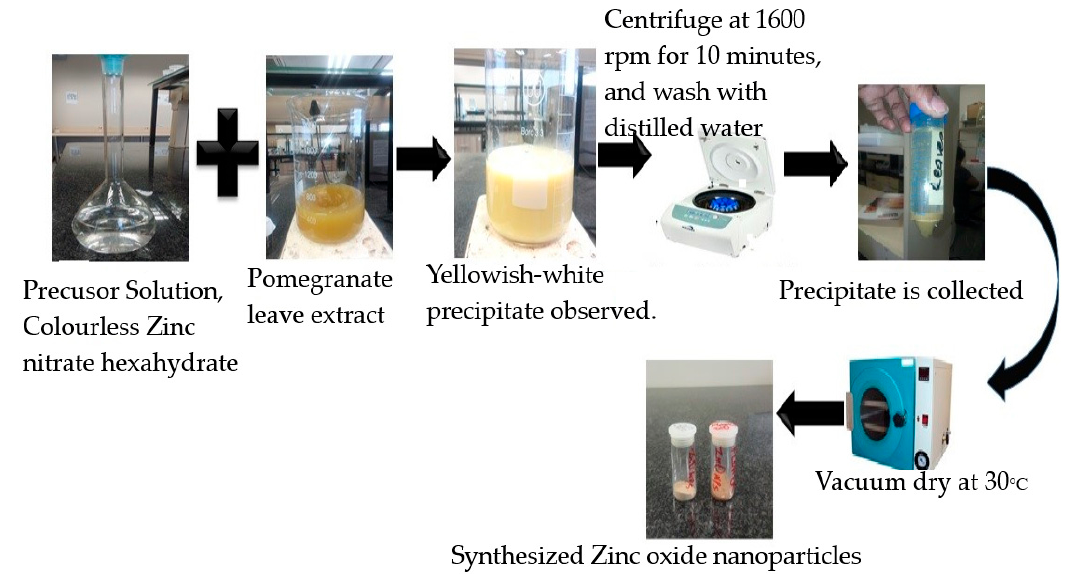
Figure 2. Synthesis of zinc oxide nanoparticles via pomegranate leaf extracts (pictorial representation).